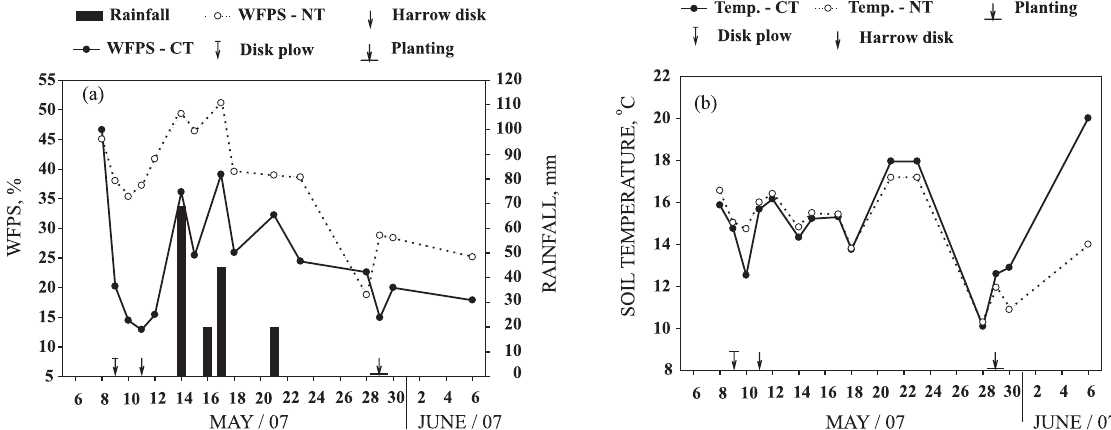
error.Figure 1. Rainfall and water-filled pore space (WFPS) (a) and soil temperature (Temp) (b) in conventional tillage (CT) and no-tillage (NT) systems, in Cruz Alta (RS), Southern